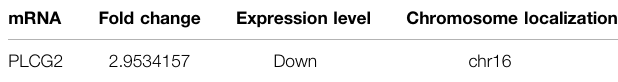
TABLE 7 | Expression of PLCG2 obtained by initial